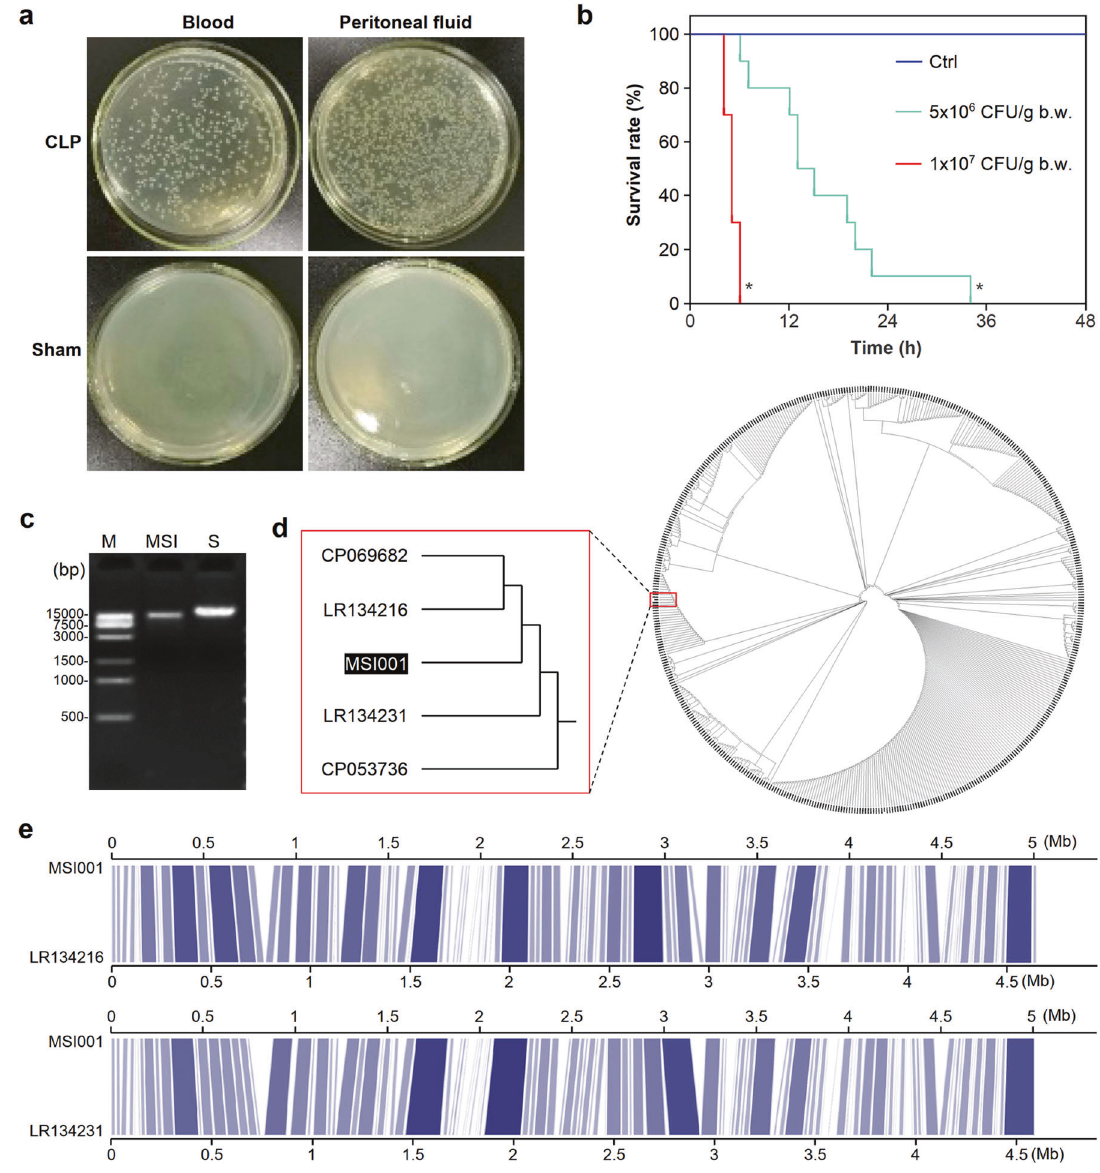
Fig. 1 Identi fi cation of a pathogenic bacterial strain from CLP mice. a Bacterial cultures with blood and peritoneal fl uid from C57 mice subjected to CLP modeling. Both blood and peritoneal fl uid were acquired from C57 mice subjected to CLP modeling or wild-type C57 mice as controls. Bacterial culture was performed on agar plates at 37 °C overnight. b Survival analysis of mice challenged with the pathogenic bacterium. C57 mice were injected with bacteria at 5 × 10 6 CFU/g body weight (low-dose group, green line) or 1 × 10 7 CFU/g body weight (high-dose group, red line. Control mice received injection of an equivalent volume of normal saline (NS). The survival of mice was observed for 48 h after peritoneal injection, and Kaplan-Meier log-rank analysis was applied to test the signi fi cance of the difference in survival between the CLP mice and the control mice. ( n = 10). * P < 0.05, compared to the control. c Agarose gel electrophoretogram of genomic DNA from the bacterial strain MSI001 . The genomic DNA extracted from bacteria was resolved by electrophoresis on a 1% agarose gel. M: DNA marker; MSI: genomic DNA extracted from the bacterial strain MSI001 ; S: DNA standard. d Phylogenetic tree for genomic DNA of the bacterial strain MSI001 isolated from CLP mice. The genomic DNA sequence of strain MSI001 was blasted against the nucleotide (nt) sequence database using BLAST + (v2.11.0) (https://ftp.ncbi.nlm.nih.gov/blast/executables/blast + /LATEST/). Marker genes were identi fi ed by using the Genome Taxonomy Database Toolkit (GTDB-Tk) as described in the Methods, and the result was input into IQ-TREE for phylogenetic inference. The Interactive Tree of Life (iTOL) was used to plot the evolution distance tree. e Visualization of whole-genome alignment (WGA) of MSI001 with the two closest reference genomic DNA samples from E. coli LR134216 (upper panel) and LR134231 (lower panel). The alignment result was visualized by Kablammo (http://kablammo.wasmuthlab.org/) with parameter settings of bit score > 10,000 and E value < 1E-10. In the fi gure, the blue lines represent the homology between the MSI001 sequence and the reference sequence. The dark intensity of the blue lines indicates the value of the bit score. The white interval in the genomic DNA of MSI001 and the E. coli strains (LR134216 and LR134231) indicates that the target sequence failed to align with the reference sequence for low bit scores or insigni fi cant E values